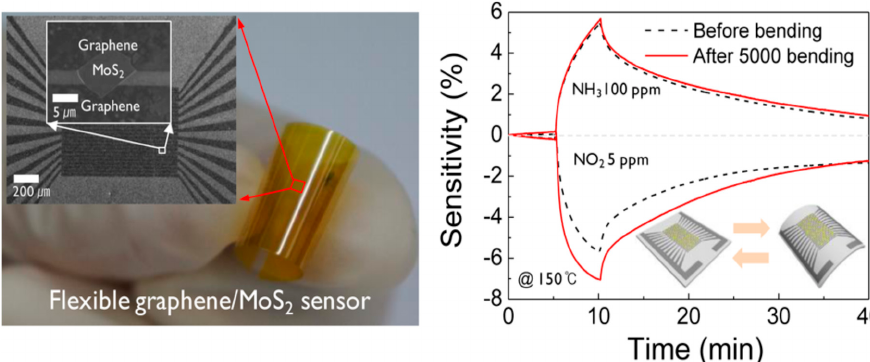
Figure 18. ( Left panel ) images of the MoS 2 -graphene heterostructure device; ( Right panel ) response of the device before and after bending to NO 2 and NH 3 . (Reproduced with permission from